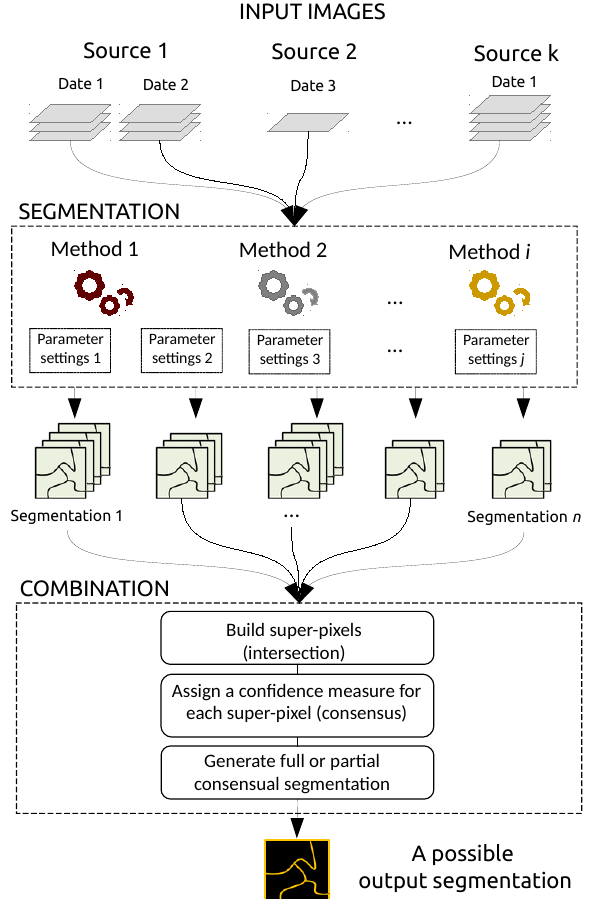
Figure 1. Our generic framework to combine multiple segmentations in the GEOBIA paradigm. Segmentations can come from different data sources (e.g., optical and radar sensors) and be acquired at different dates. They may also be produced using different methods (e.g., region-based or edge-based) relying on different parameter